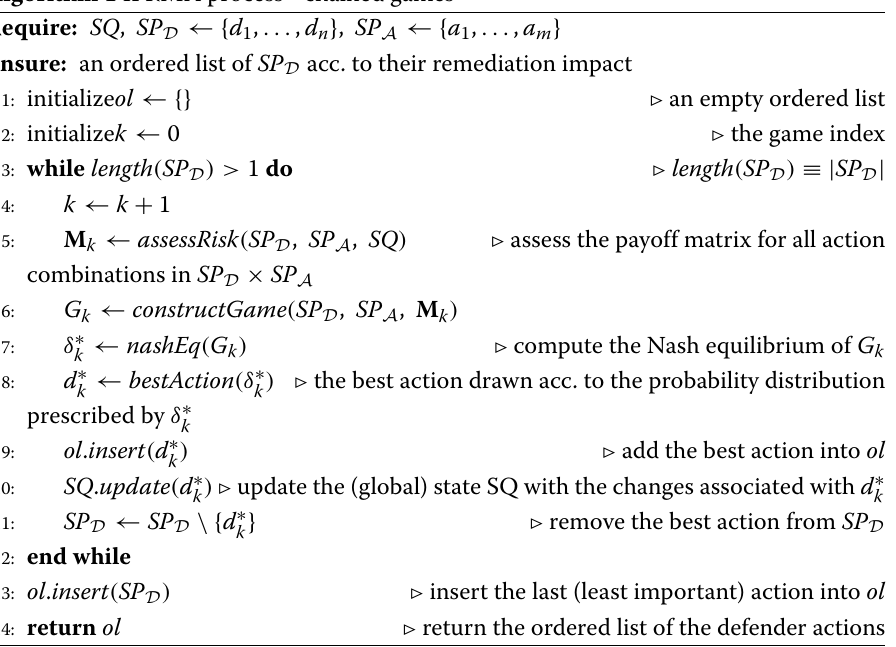
Algorithm 1 IPRMA process - chained